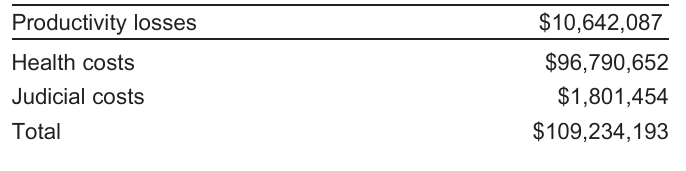
Table 3 . Total economic burden of intimate partner violence in Ecuador, 2012 US dollars.